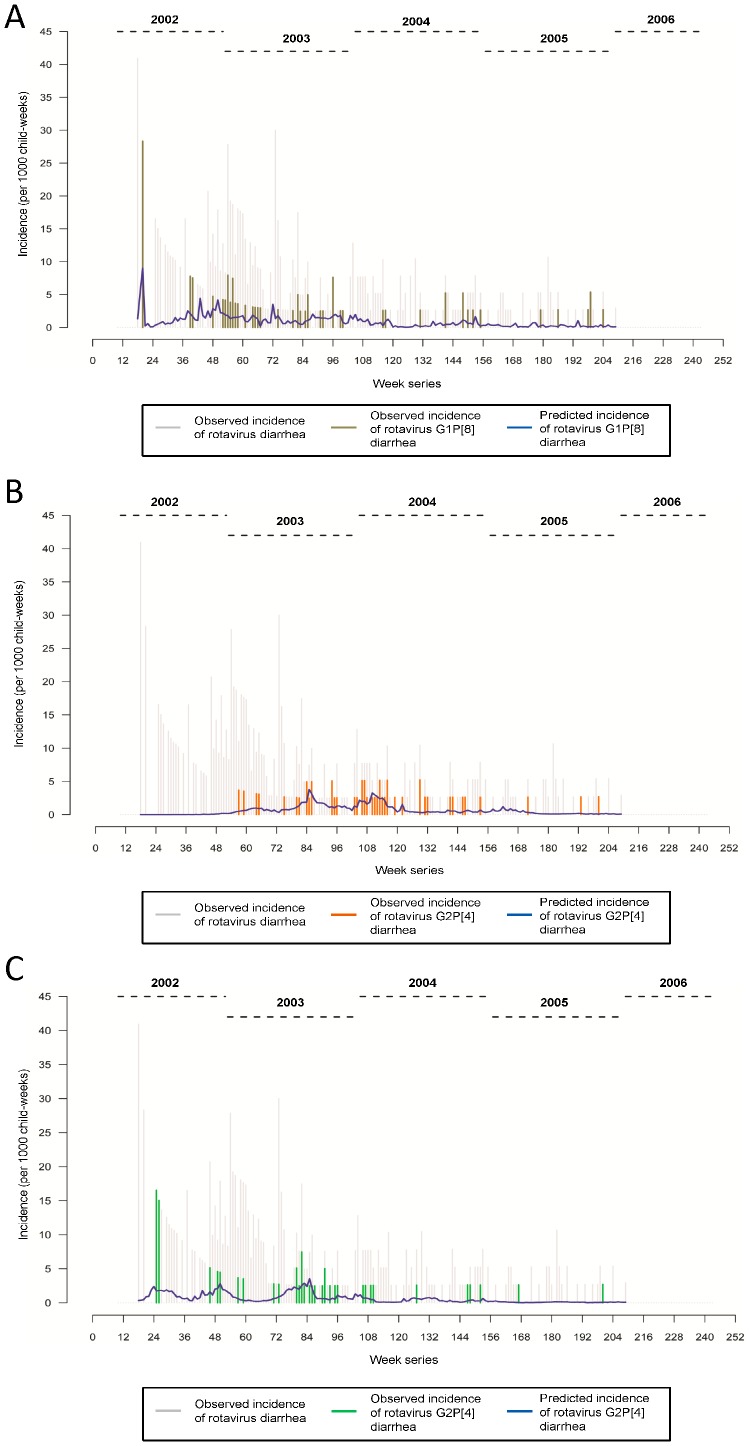
Week-series of incidence of diarrhea (per 1000 child-weeks) due to major rotavirus strains (A) G1P [8], (B) G2P [4], (C) G1P [4].The colored horizontal spikes (khaki for G1P [8], orange for G2P [4] and green for G1P [4]) represent the observed strain-specific incidence of rotavirus diarrhea among children in the cohort. The vertical blue line depicts the predicted incidence derived from the Poisson harmonic regression model.